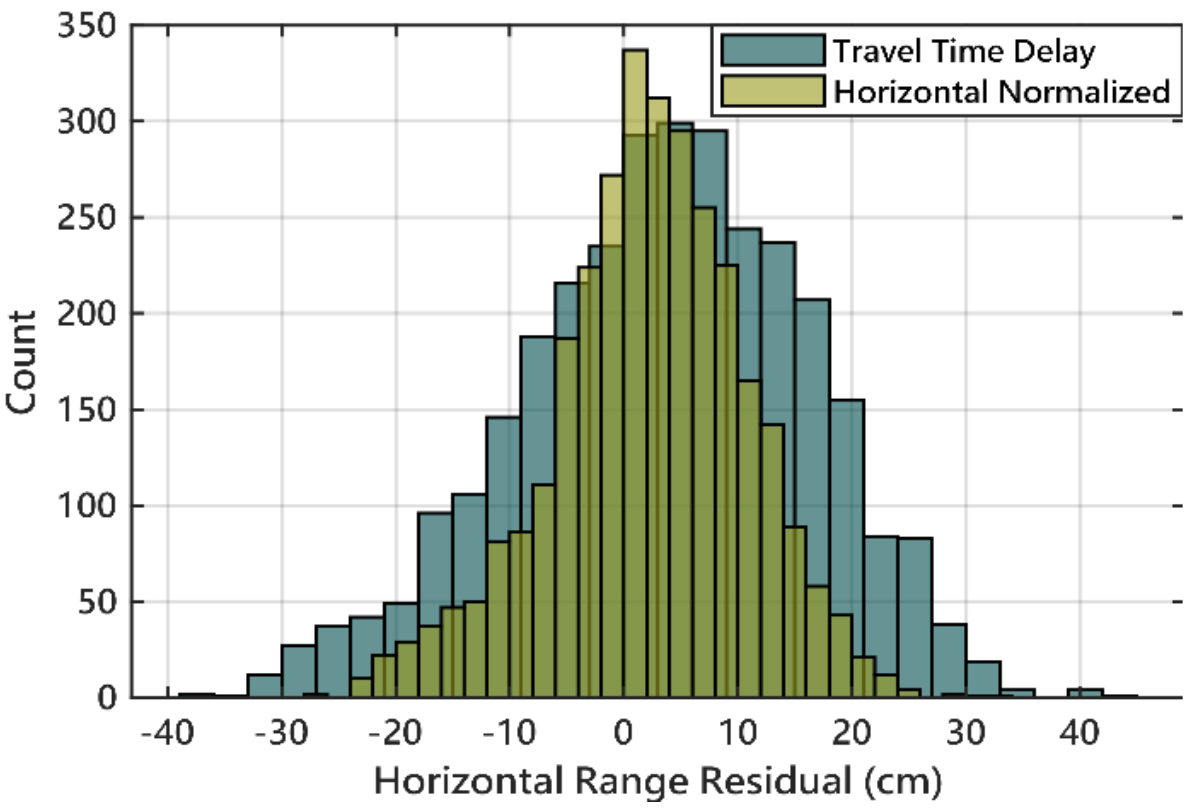
Figure 10. The histogram of circle line acoustic horizontal range residuals for the LS method with round-trip travel time delay and horizontal normalized travel time delay.